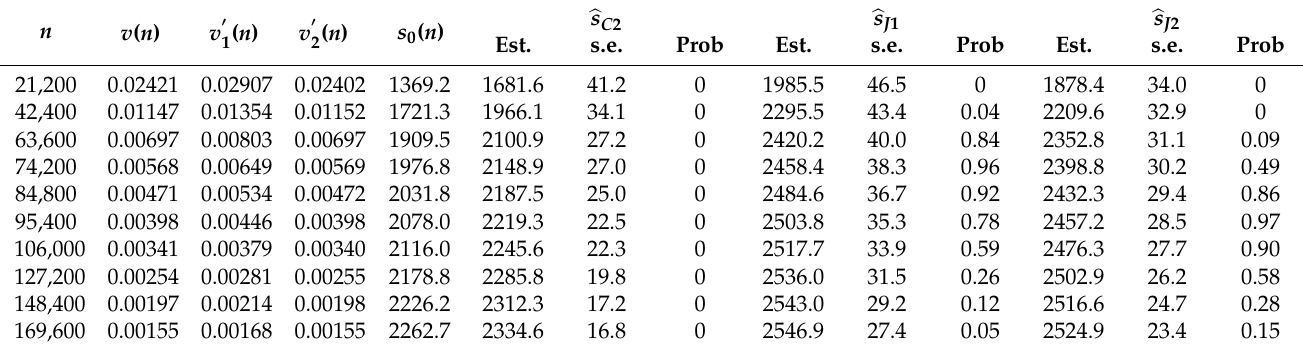
Table 6. Chinese Novel Data (Numbers of species in two populations are s 1 = 2591 & s 2 = 3690 and the number of shared species is s 0 = 2457; J 1 & J 2: 1st & 2nd Jackknife estimates, C 2: Chao’s estimate, s 0 ( n ): number of observed shared